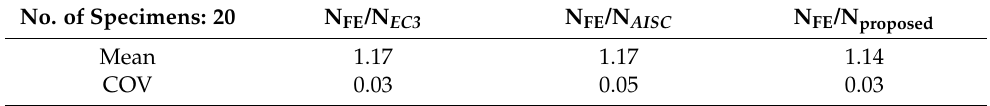
Table 5. Comparison of proposed design method and code predictions with FE results of